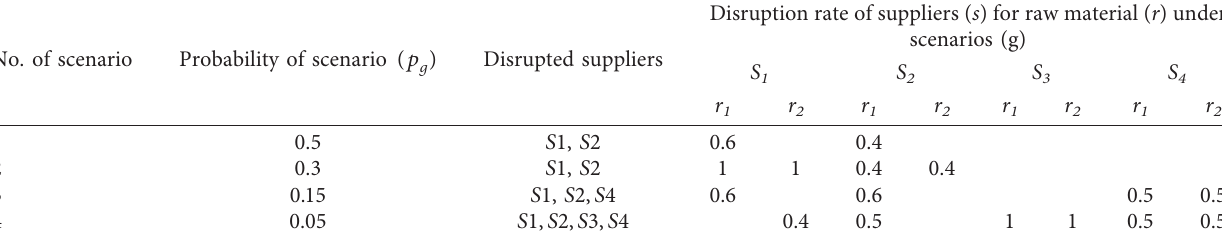
Table 4: Disruption scenarios for